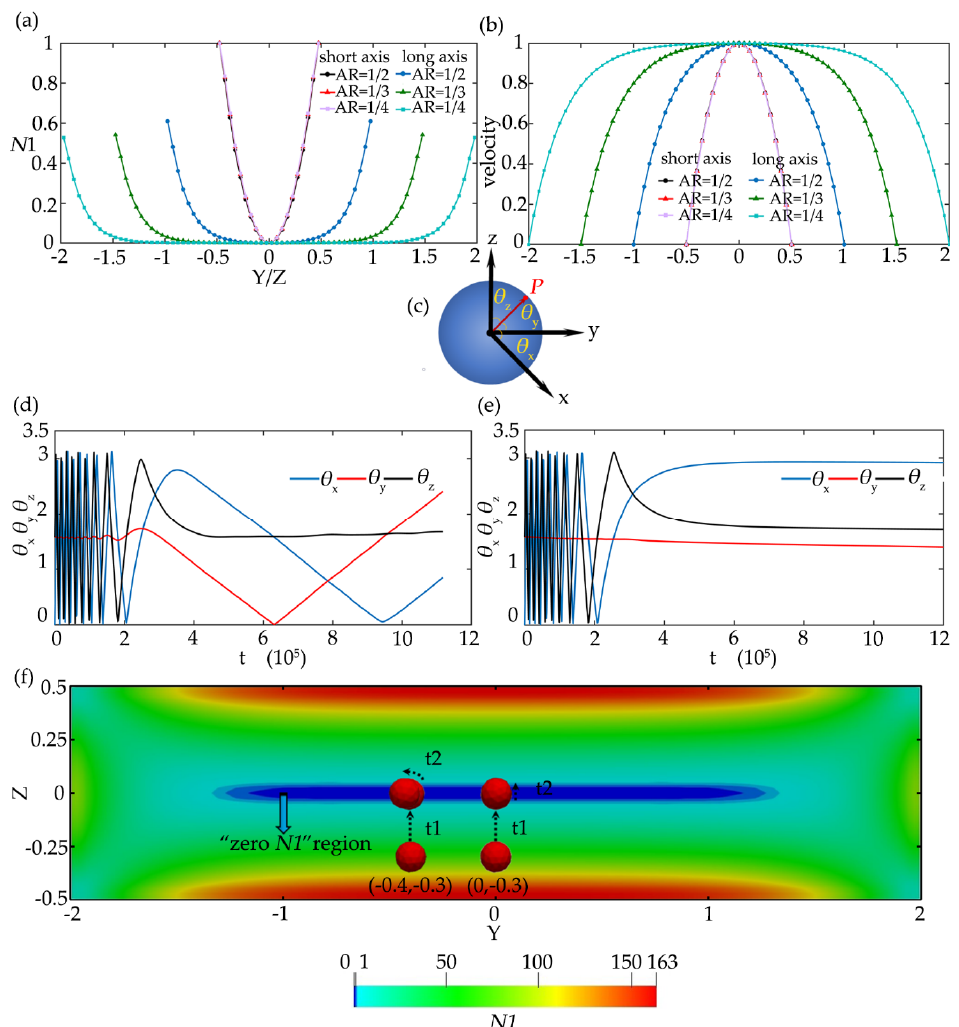
Figure 8. The non-dimensionalized the first normal stress difference N 1 distributions ( a ) and velocity distribution ( b ) on the long symmetry axis and the short symmetry axis of the cross section of the channel with AR = 1/2, 1/3, and 1/4. ( c ) Schematic diagram of the vector P and the angles θ x , θ y , and θ z between the vector P and the coordinate axis. Time history of θ x , θ y , and θ z of the particle with d / h = 0.15 in the channel with AR = 1/4 at the initial position ( d ) ( − 0.4, − 0.3) and ( e ) (0, − 0.3). ( f ) Schematic diagram of particle migration on the cross-section of the channel, t 1 = 300,000 dimensionless time units, t 2 = 900,000 dimensionless time units.